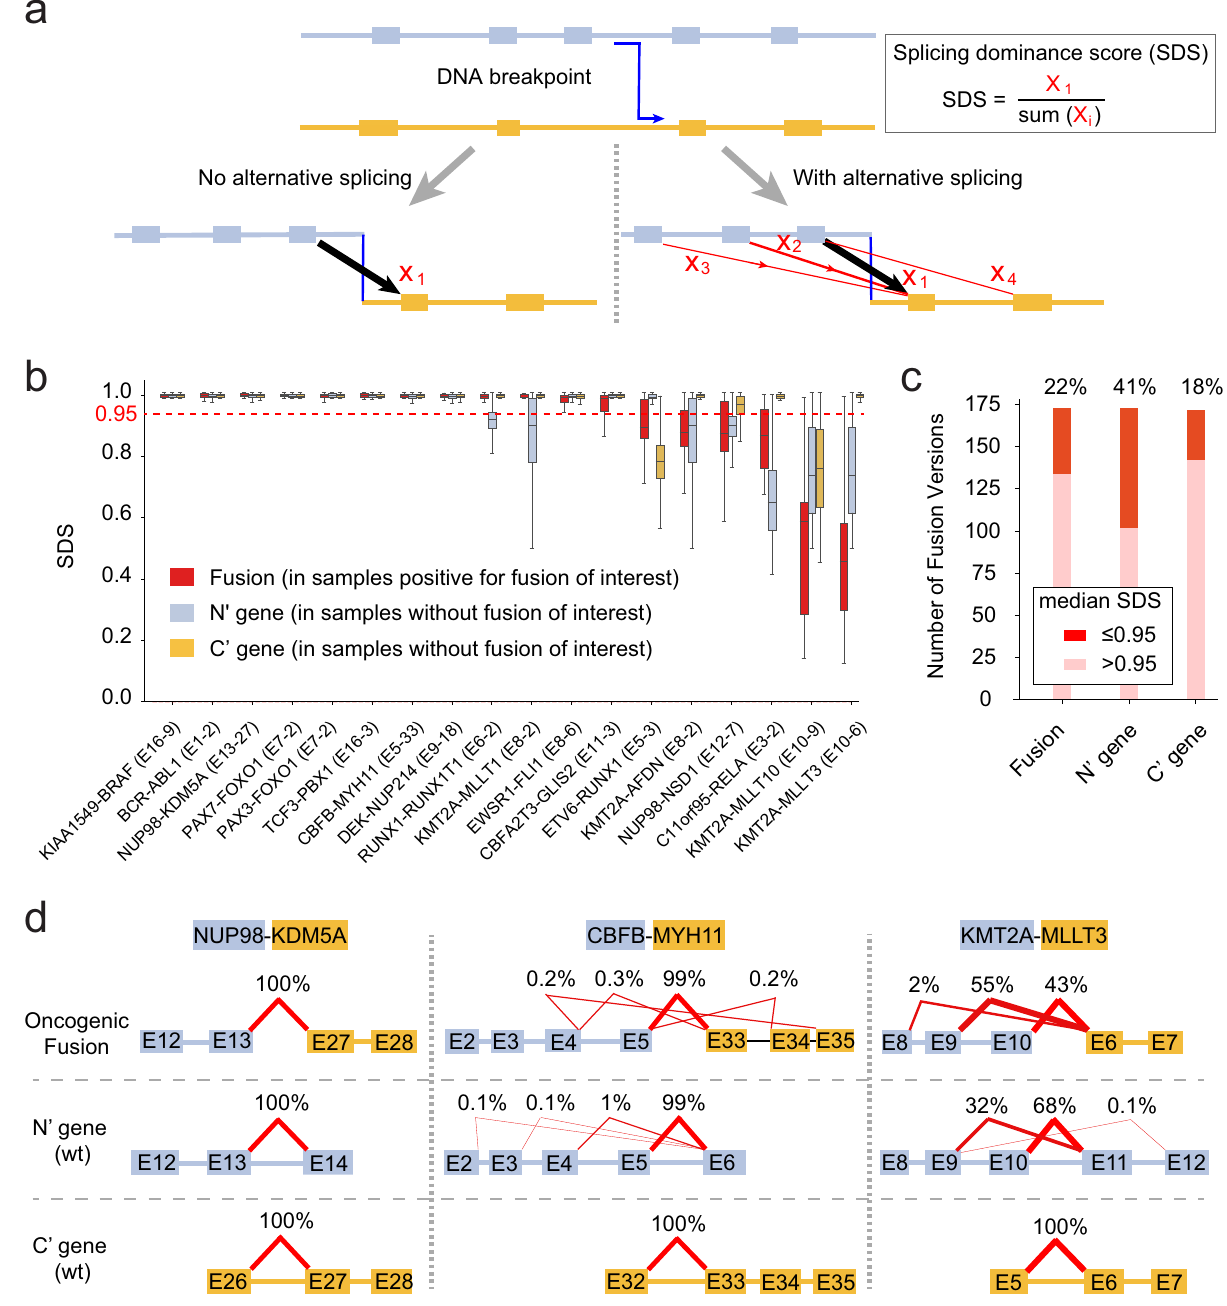
Fig. 4 | Alternative splicing in oncogenic fusions. a Splicing model. The onco- genic fusion de fi ned by a DNA breakpoint (blue line) mayor may not besubjectto alternative splicing (red lines). We propose a splicing dominance score (SDS) to measurethealternativesplicingasaratioofthecountofsplicingreadssupporting the canonical splicing pattern( X 1 ) to the count ofsplicing reads spanning both the N ’ gene and the C ’ gene ( X 1 – X 4 ). A similar score is de fi ned for the wildtype genes (Methods; Supplementary Fig. 6). b SDS score distribution for fusion genes (red) and wildtype N ’ (blue) and C ’ (orange) genes for 18 intronic versioning with